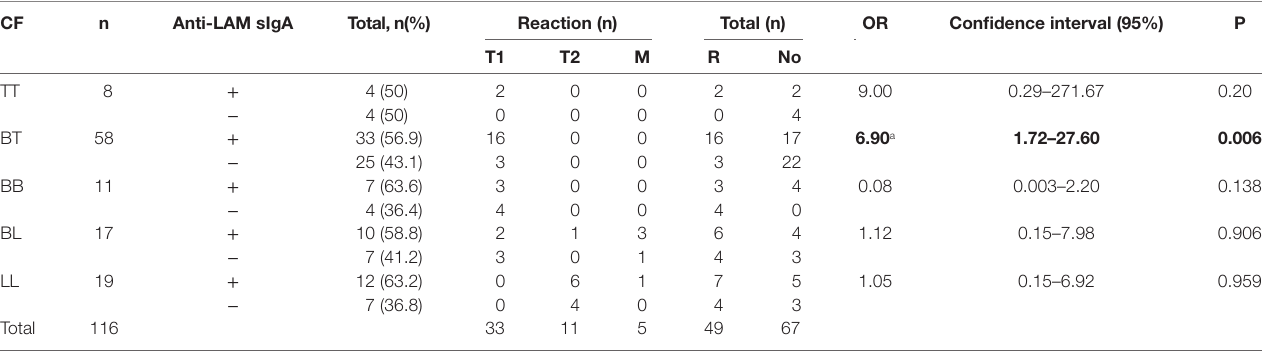
Table 2 | Frequencies of leprosy patients by CF, type of leprosy reactions, and positivity for salivary anti-lipoarabinomannan (LAM) sIgA, followed by odds ratios (OR), confidence interval at 95% (CI 95% ), and probability levels (P) toward the occurrence of reactions. cF n